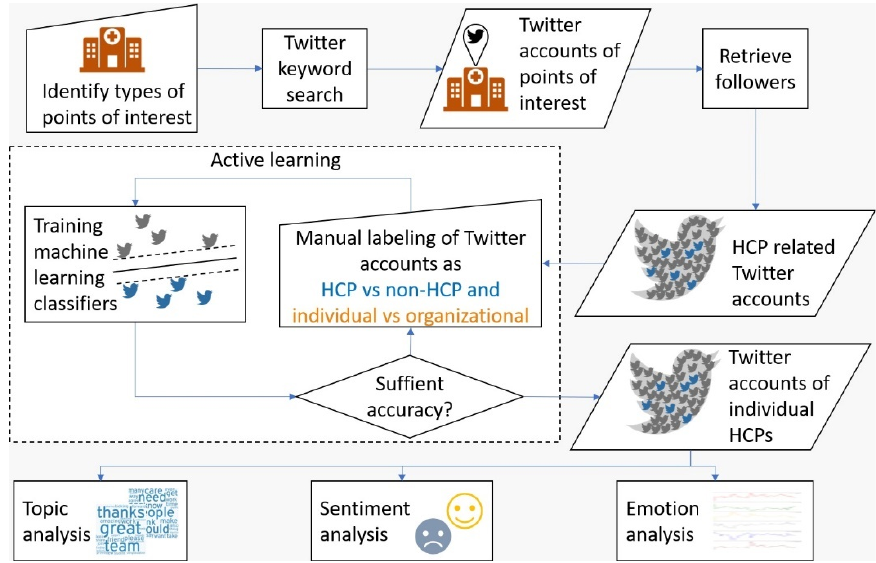
Figure 1. Steps of study methodology.